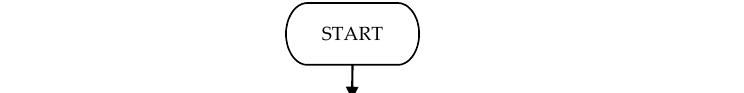
Table 1. Some parameter indexes of hydropower station.